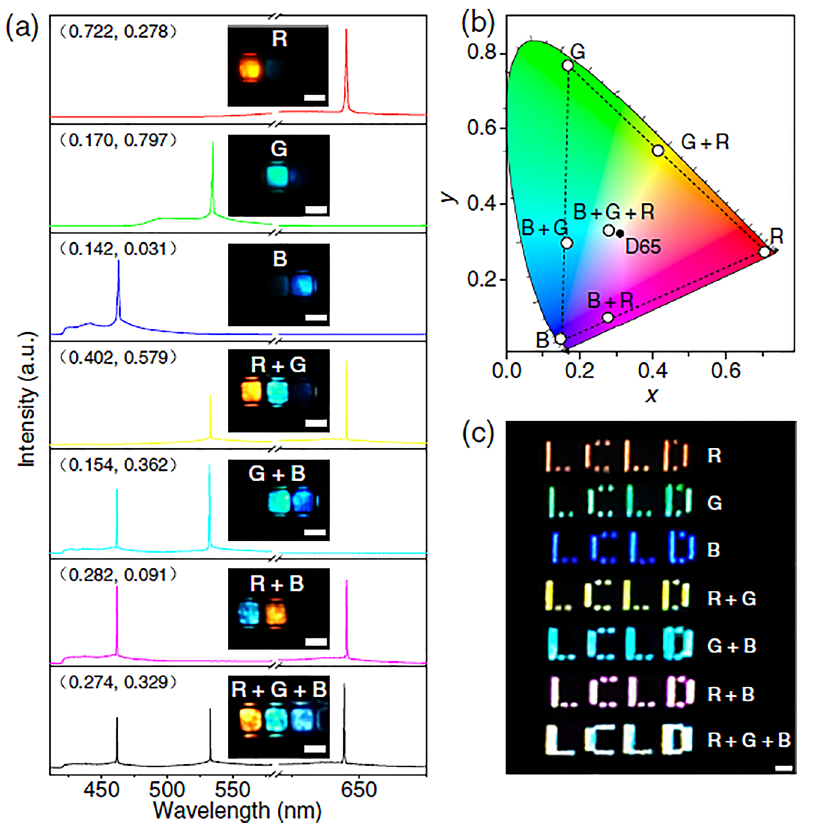
Figure 29: Full-color lasing combinations from RGB subpixels. (a) Lasing spectra of different combinations of RGB subpixels. Insets: Corresponding PL images and CIE1931 coordinates calculated from respective spectra. Scale bars = 20 μ m. (b) Chromaticity distribution of the lasing peaks on the CIE1931 color diagram. The peaks were extracted from seven spectra in (a). (c) Far- fi eld photograph of the “ LCLD ” patterns composed of different RGB pixel arrays. The photograph was captured by a built-in digital camera in a cell phone. The scale bar is 150 μ m